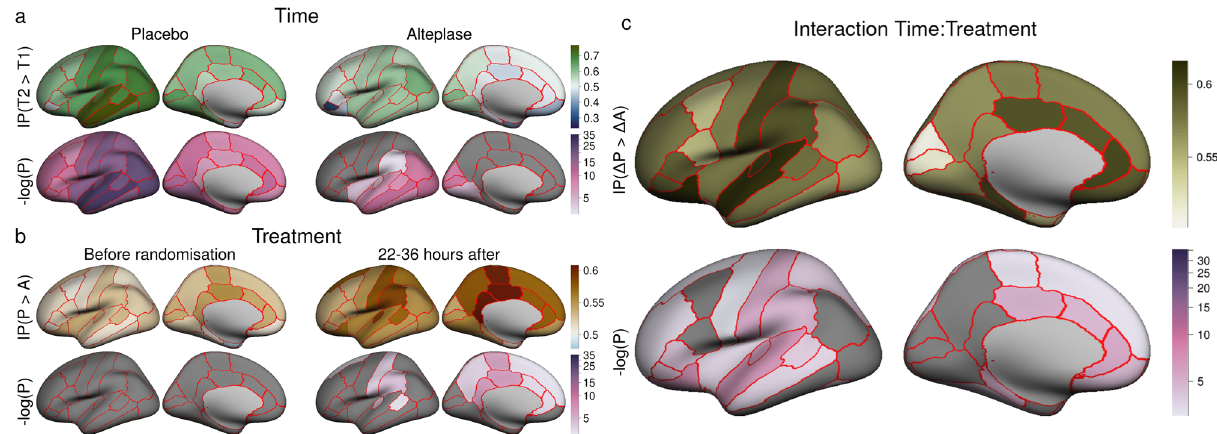
Fig. 2 Non-parametric mass univariate analysis of effects of time and treatment allocation on loss of connectivity. In each panel, measures of effect size (top) and surprisal 51,62 , i.e. s = − log(P), (bottom) for each cortical parcel of the Desikan – Killiany atlas, are visualized as colored regions on the FreeSurfer standard template brain. The logarithmic scale for surprisal is identical across panels. Dark grey patches on surface representations correspond to uncorrected P values > 0.05. For corresponding numerical data see Supplementary Table 3. a Effect of time is quanti fi ed as the estimated probability ℙ (T2 > T1) that network disruption scores are higher at T2 than at T1 and assessed using Wilcoxon signed-rank tests. b Effect of treatment allocation is quanti fi ed as the estimated probability ℙ (P > A) that network disruption scores are higher in the placebo than in the alteplase group and assessed using Mann – Whitney U tests. c Interaction between time and treatment allocation is quanti fi ed as the estimated probability ℙ ( Δ P > Δ A) that within-subject change (T2 – T1) of network disruption scores is higher in the placebo than in the alteplase group and assessed using Mann – Whitney U tests. All P values are two sided.